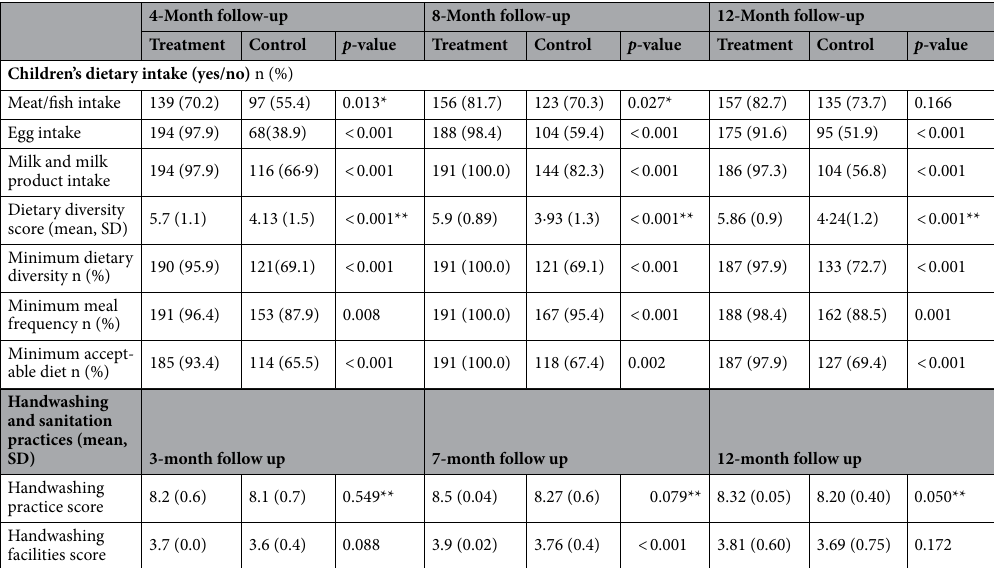
Table 4. Effects of the intervention on dietary intake, handwashing and WASH practices. * p values were calculated from mixed effect logistic regression model where cluster were adjusted. ** p values were calculated from mixed effect linear regression model where clusters were